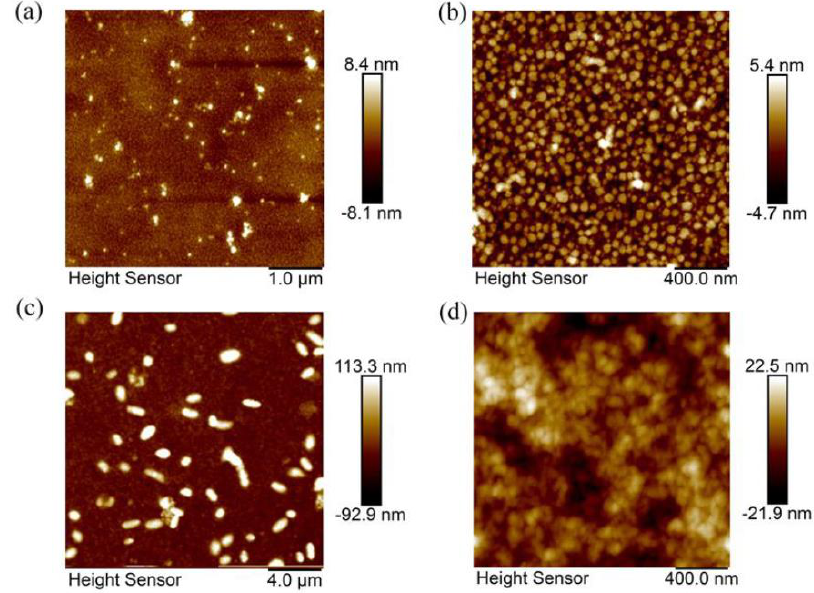
Figure 2. Atomic force microscope (AFM) images of N-CQDs. Low-magnification images of N-CQDs: ( a ) ON-CQDs (5 µm) and ( c ) WN-CQDs (20 µm). ( b ) and ( d ) are high-magnification images (2 µm) of ON-CQDs and WN-CQDs, respectively.